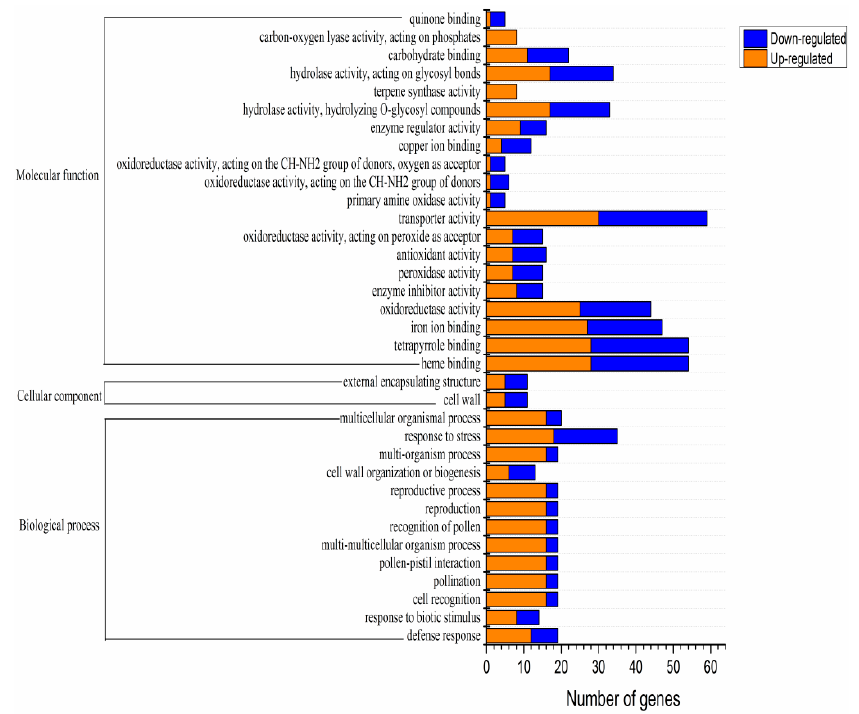
Figure 3. Gene Ontology (GO) annotation classification summary of the russet CKY versus non-russet CKN di ff erentially expressed genes.